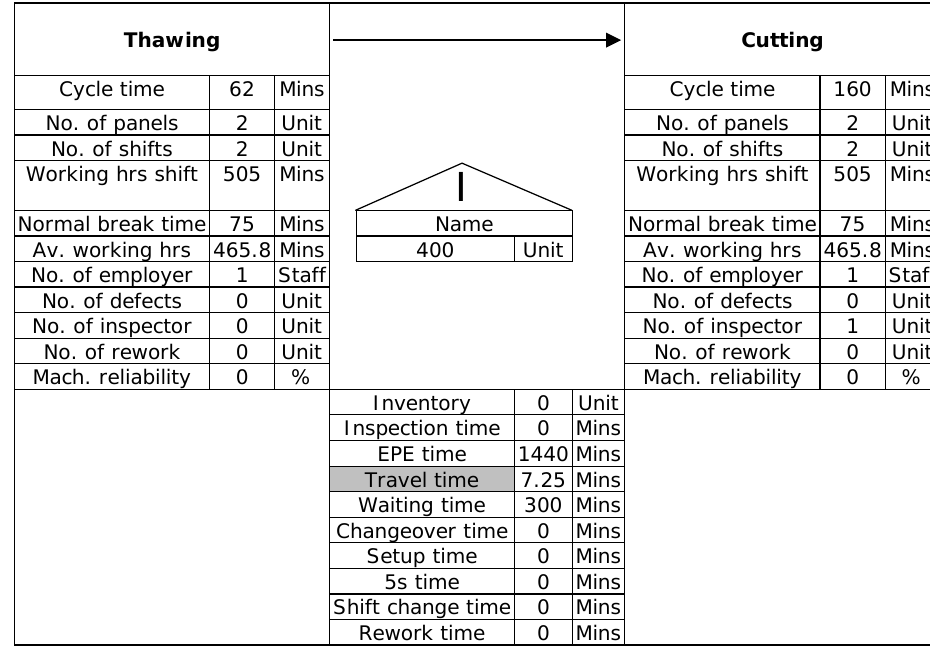
Figure 3. “Travel time wastages (Thawing to